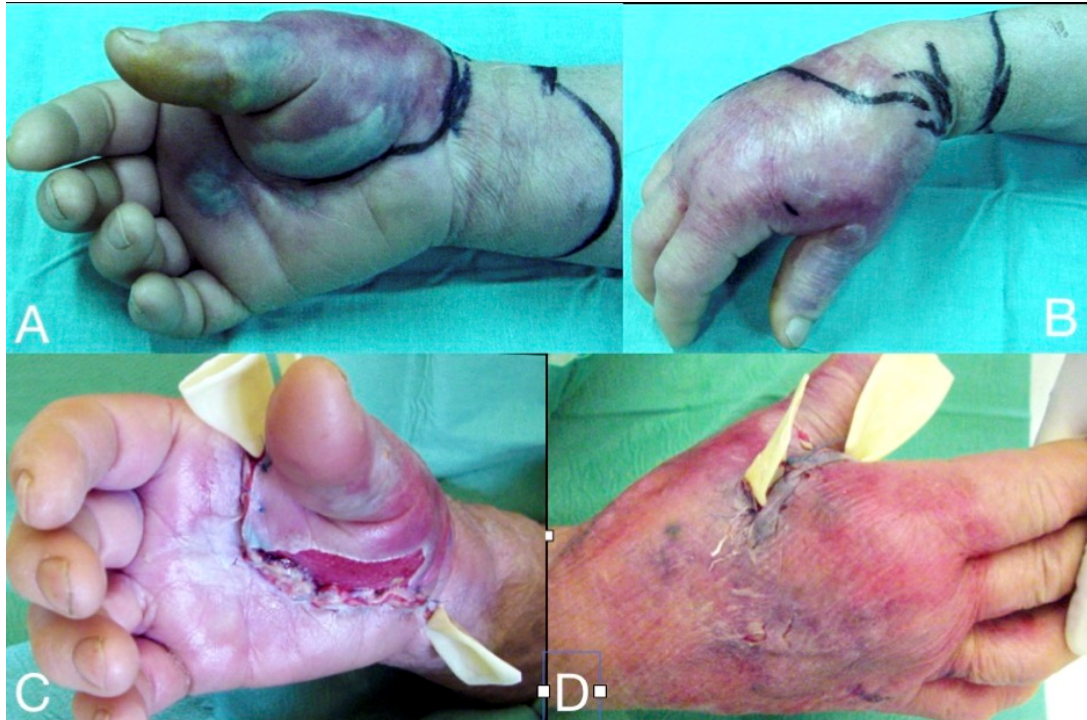
Figure 2. Deep infection at the thenar and the mid-palmar spaces, one week after a penetrating injury at the palmar aspect of the 1 st phalanx of the thumb. The markings ( A , B ) demonstrate the margins of cellulitis at presentation, which improved significantly after administration of iv clindamycin and aminoglycoside for 24 h. Through a palmar incision, the palmar inter-muscular space of the thenar and the mid-palmar space were drained and debrided ( C ), followed by the dorsal thenar compartment debridement ( D ). The elastic tubes serve for the drainage until the wounds become dry.